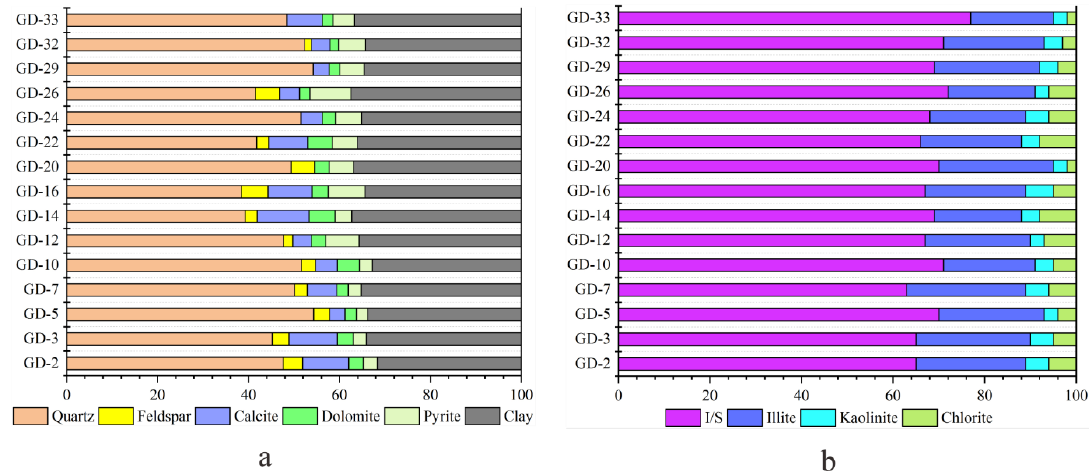
Figure 3. Distribution diagrams of mineral composition ( a ) and clay mineral ( b ).